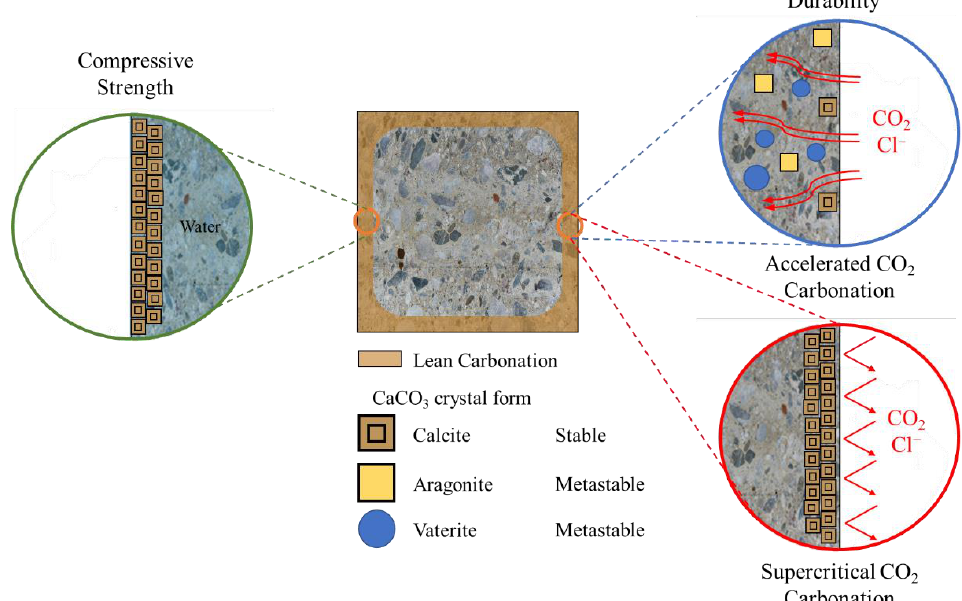
Figure 8. Expected effects of Lean Carbonation.